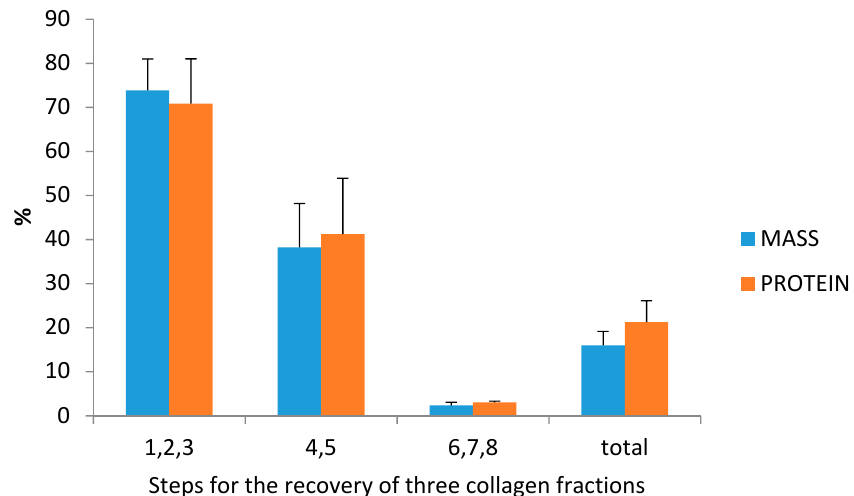
Figure 5. Percentages of retained mass and protein within the different steps involved in the recovery of collagen from the skin and bone fraction (SBF) of M. merluccius undersized specimens. Values are means and standard deviations obtained from three different extraction procedures. The different steps involved in the recovery of the collagen fractions are explained in Figure 1.